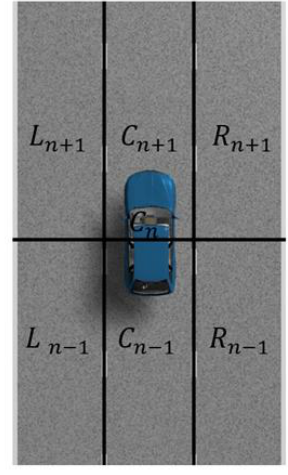
Figure 2. Schematic diagram of a three-lane vehicle-following model cluster environment.